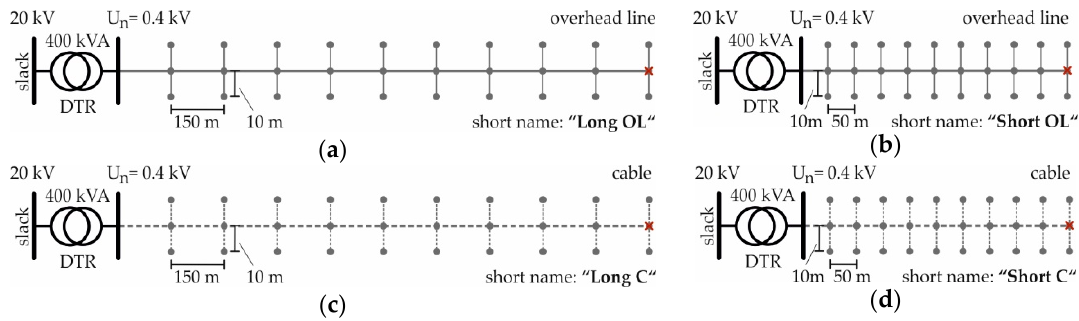
Figure 1. Theoretical LV test-feeders: ( a ) long overhead line feeder (“Long OL”); ( b ) short overhead line (“Short OL”); ( c ) long cable (“Long C”); ( d ) short cable (“Short C”).